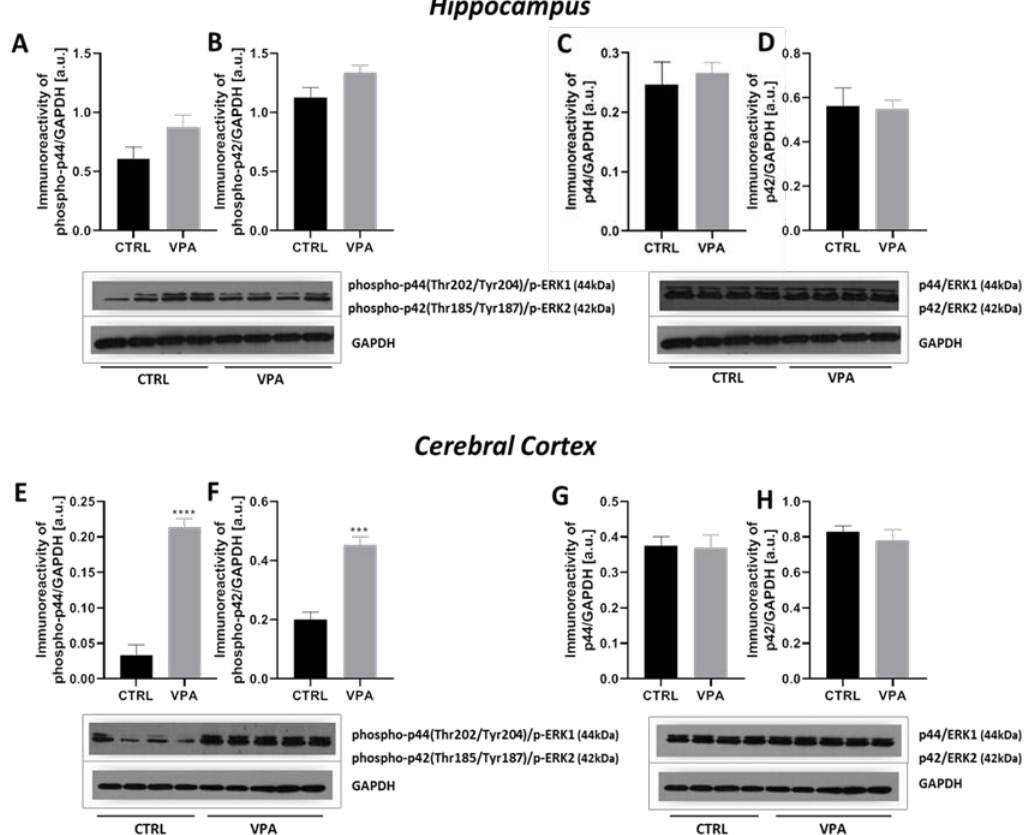
Figure 11. The effect of prenatal exposure to VPA on the p44/p42MAPK (ERK1/2) in the rat brain. Immunoreactivity of phospho-ERK1(Thr202/Tyr204), phospho-ERK2(Thr185/Tyr187), ERK1, and ERK2 were monitored using Western blot analysis. Densitometric analysis and representative pictures of phospho-ERK1, phospho-ERK2 as well as total ERK1 and ERK2 in the hippocampus ( A – D ) and cerebral cortex ( E – H ) were shown. Results were normalized to GAPDH levels. Data represent the means ± S.E.M. from n = (4–9) independent experiments in the hippocampus: ( A ) n = 9 (CTRL), n = 8 (VPA); ( B ) n = 9 (CTRL), n = 8 (VPA); ( C ) n = 5 (CTRL), n = 4 (VPA); ( D ) n = 5 (CTRL), n = 4 (VPA); and n = (3–5) in the cerebral cortex: ( E ) n = 3 (CTRL), n = 5 (VPA); ( F ) n = 3 (CTRL), n = 5 (VPA); ( G ) n = 4 (CTRL), n = 5 (VPA); ( H ) n = 4 (CTRL), n = 5 (VPA).*** p < 0.001, **** p < 0.0001 vs. control.